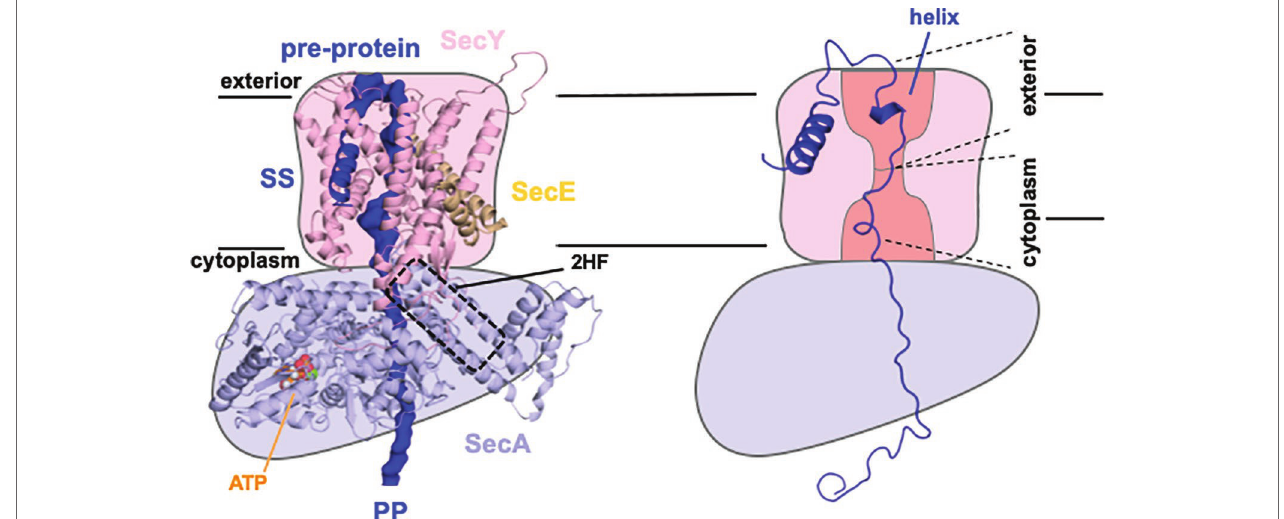
FIGURE 2 | Sec control of protein folding as a driver for transport. Model structure of SecYEG-SecA ATP based on Li et al. (2016) with key features labeled accordingly; SS, signal sequence; 2HF, 2 helix finger (left). Schematic of same (right), showing only the simulated structure of the pre-protein, with a partial folding in the exterior cavity (helix) and unfolded regions in the cytoplasmic cavity and hence favoring transport to the exterior, as required. Adapted from figures shown previously, used with permission (Corey et al.,